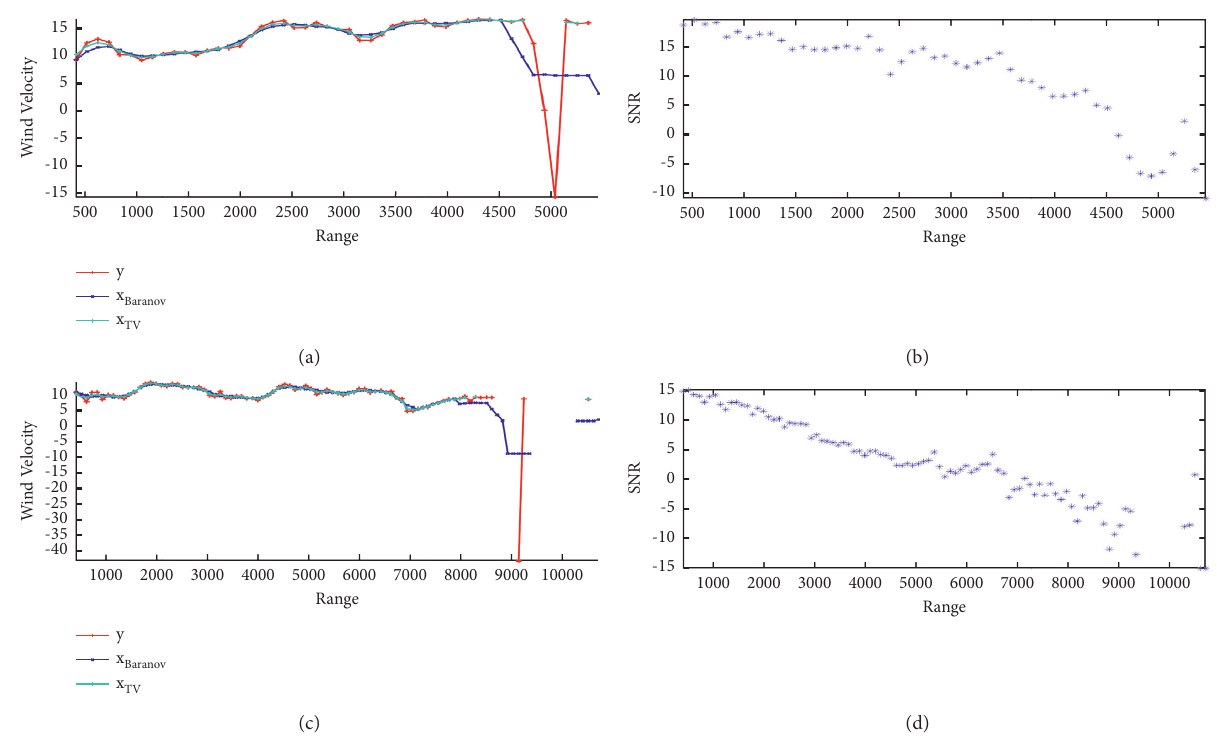
Figure 5: The denoising results by the proposed method x from 21:26 :16 to 21: 46:39 with a fixed azimuth angle 314 ° and the denoising results. (b) The SNR values of the LiDAR data in the 1st row. (c) The LiDAR data were on 5 March 2015 from 04 :16:02 to 04:16: 25 with a fixed azimuth angle 277 ° and the denoising results. (d) The SNR values of the LiDAR data in the 3rd